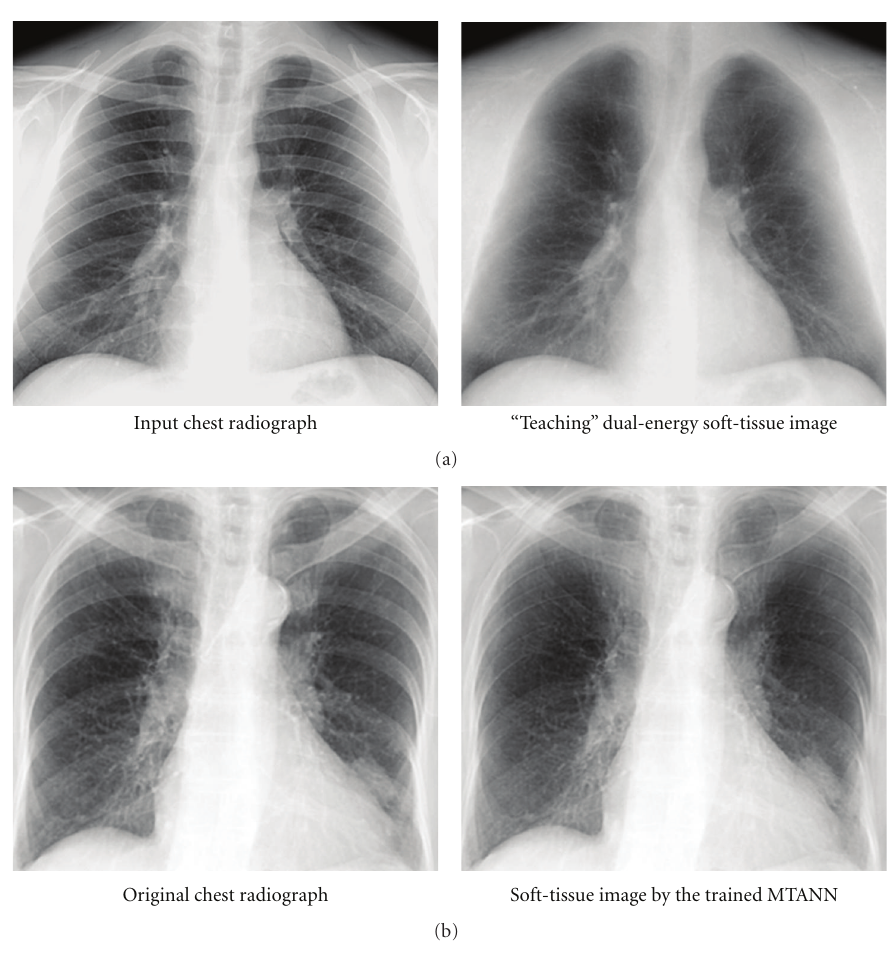
Figure 8: Separation of bones from soft tissue in CXRs by use of an MTANN. (a) Images used for training the MTANN. (b) Result of an application of the trained MTANN to a nontraining